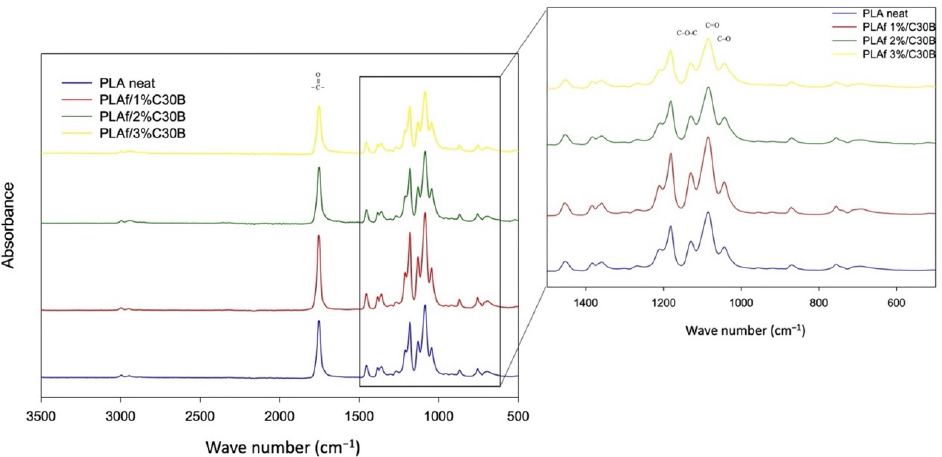
Figure 6. Fourier-transform Infrared Spectroscopy (FTIR) spectra of PLA bionanocomposite and neat foams.